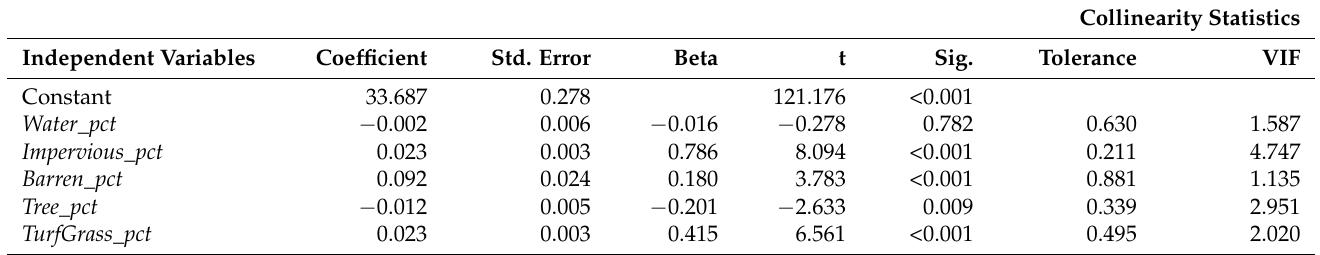
Table 1. Regression analysis of ambient temperature and land cover types ( N =